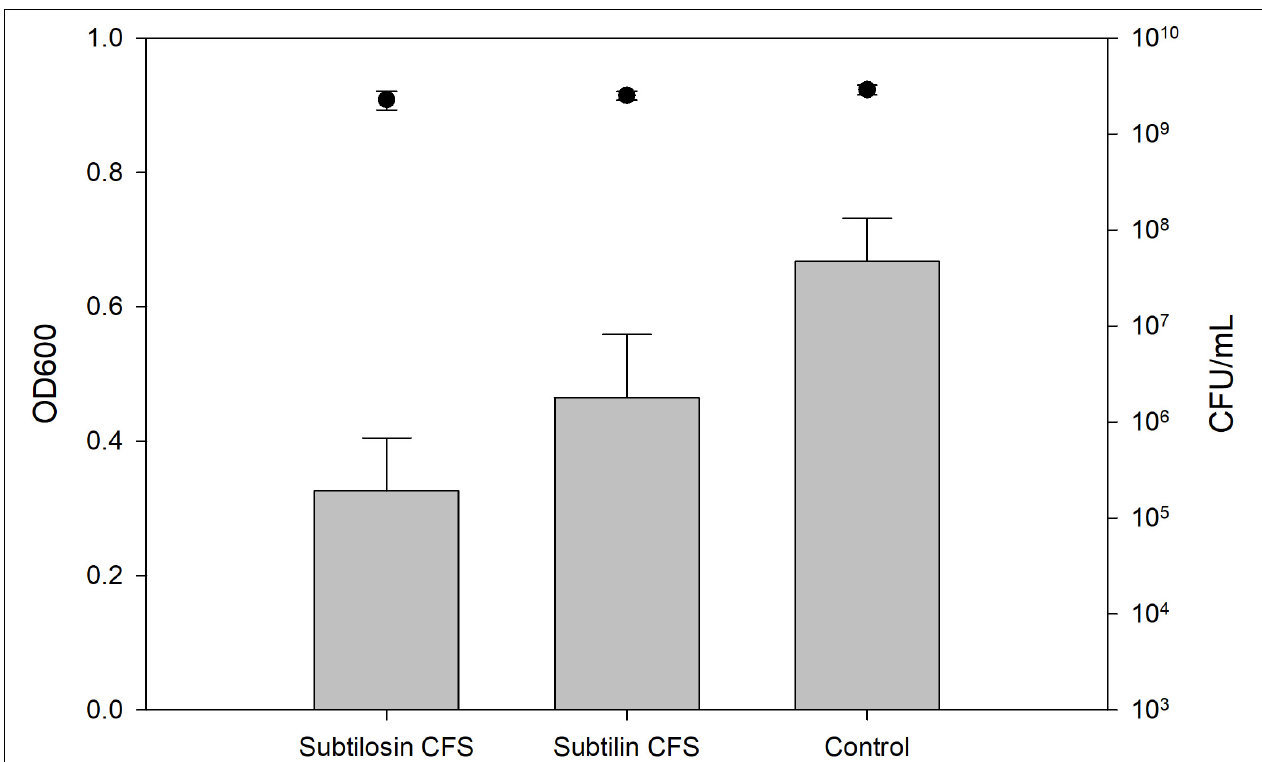
FIGURE 2 | Salmonella Hadar biofilm inhibition by B. subtilis KATMIRA1933 (subtilosin) and B. amyloliquefaciens B-1895 (subtilin) (gray bars) and the planktonic cell count (black